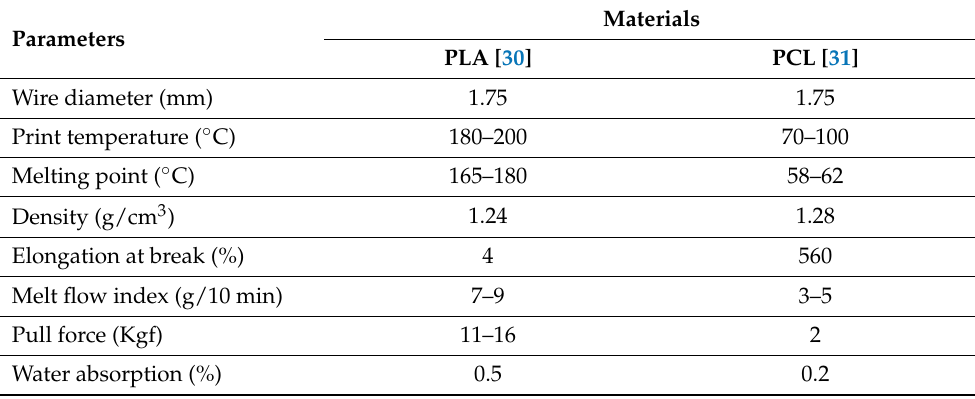
Table 1. PLA and PCL filament